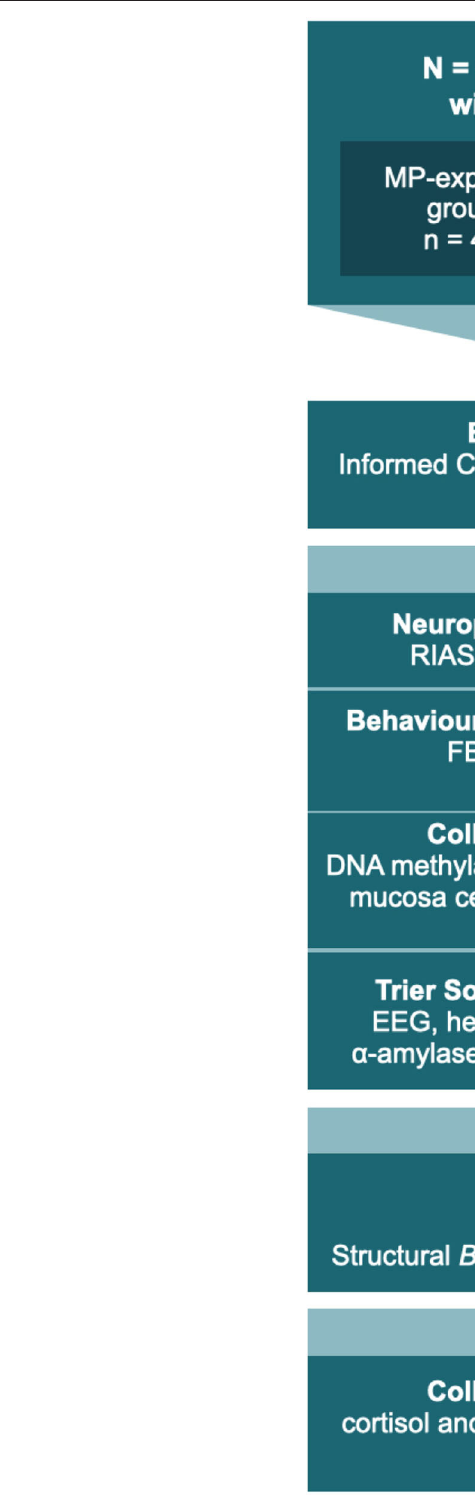
Frontiers in Neurology |